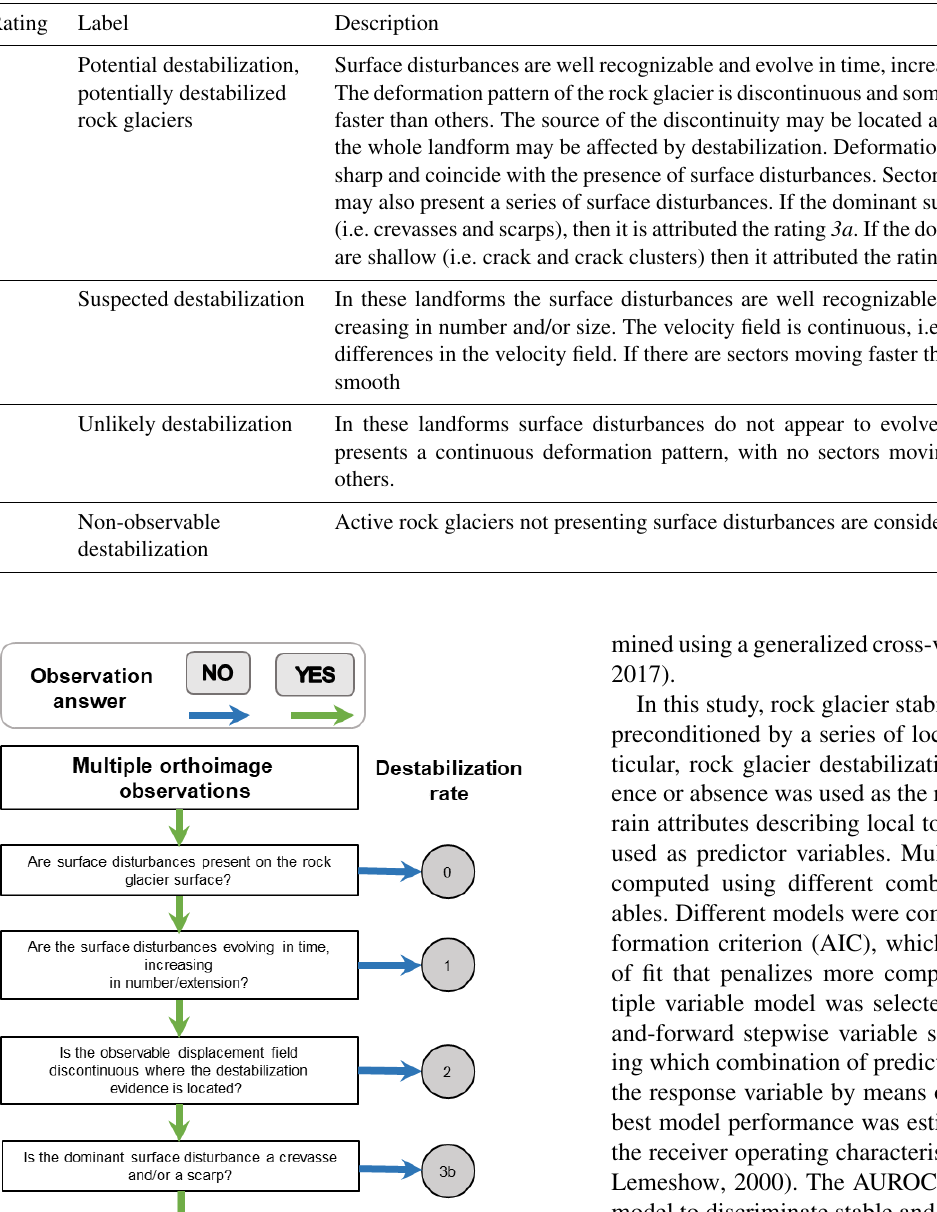
Table 2. Rating classes used to describe rock glacier destabilization.